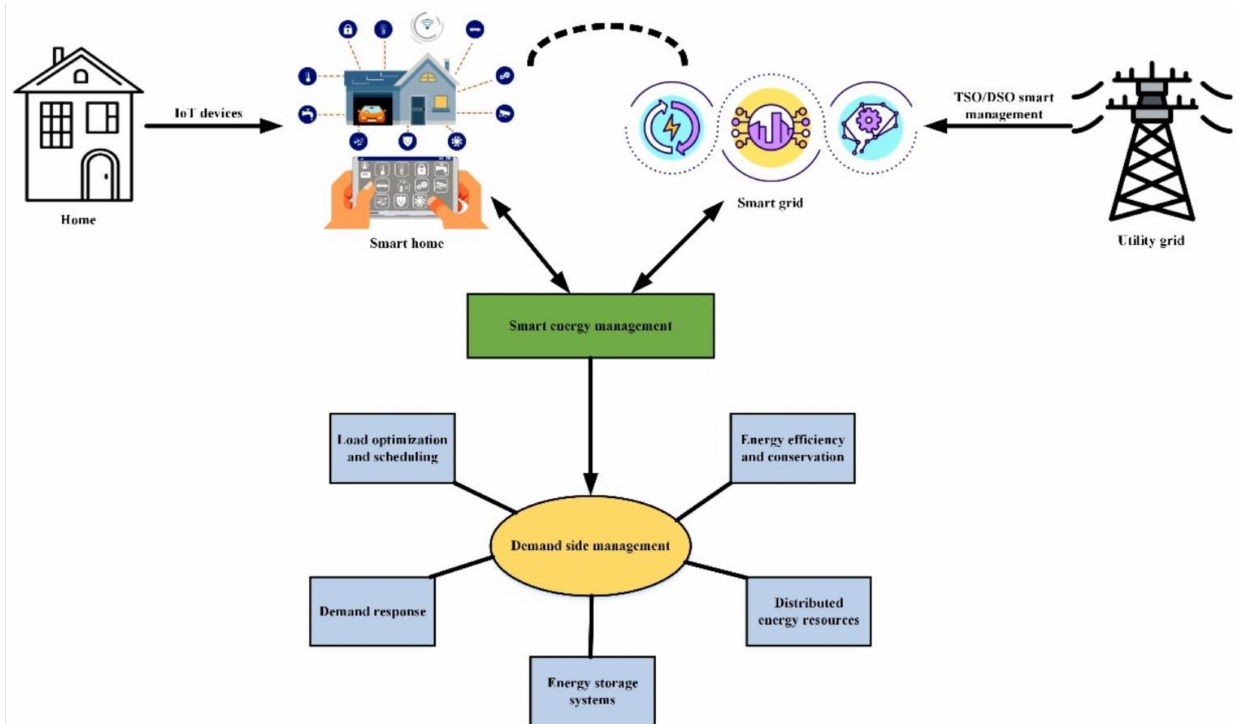
Figure 2. Principle of DSM in the smart grid environment.